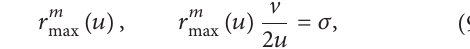
Figure 6: Reference tag boresight threshold power 𝑃 for the studied cases: (a) upper arm case, 𝐻 -plane ( 𝑧𝑦 -plane) measurement; (b) chest, 𝐸 -plane ( 𝑧𝑥 -plane) measurement; and (c) head, 𝐸 -plane ( 𝑧𝑥 -plane)